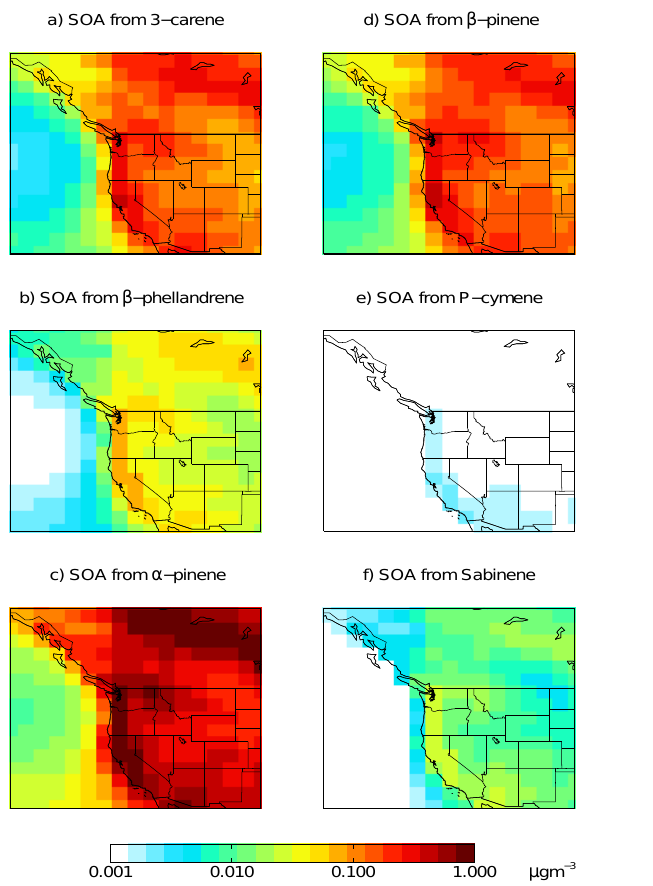
Fig. 8. Change in simulated summer-mean SOA concentration from all six monoterpenes due to the impact of both mountain pine beetle and other beetle attack in 2002, 2004, and 2008 (in the pine sce- nario). Change due to the mortality effect alone (a–c) and mortality effect plus the attack effect (d–f) . The color bar is saturated at